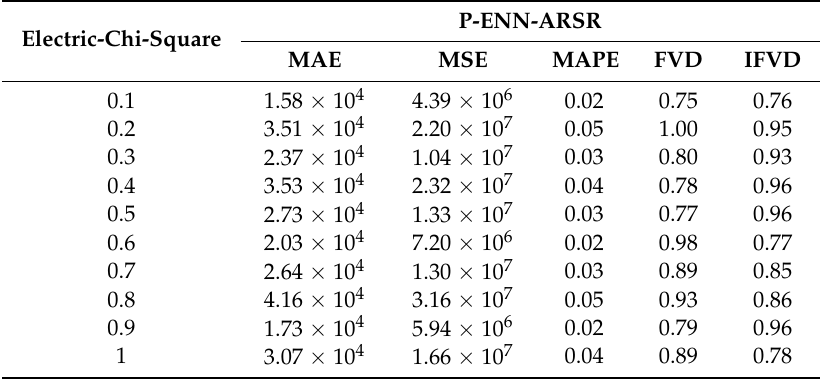
Table 7. Results of P-ENN-ARSR for EL forecasting at 5-h intervals.